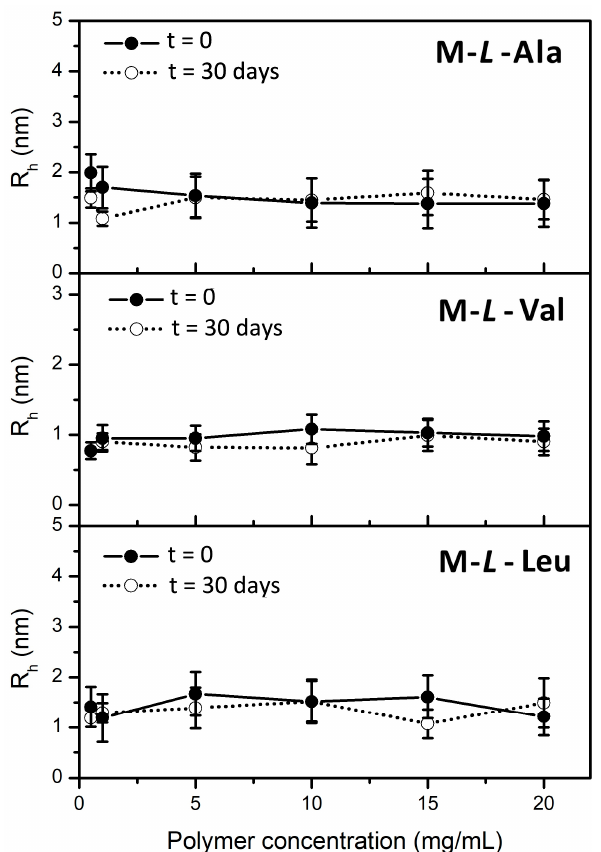
Figure 8. Concentration dependence of PAAC hydrodynamic radius in Milli-Q water pH 4.74 ± 0.72 at 0 and 30 days.